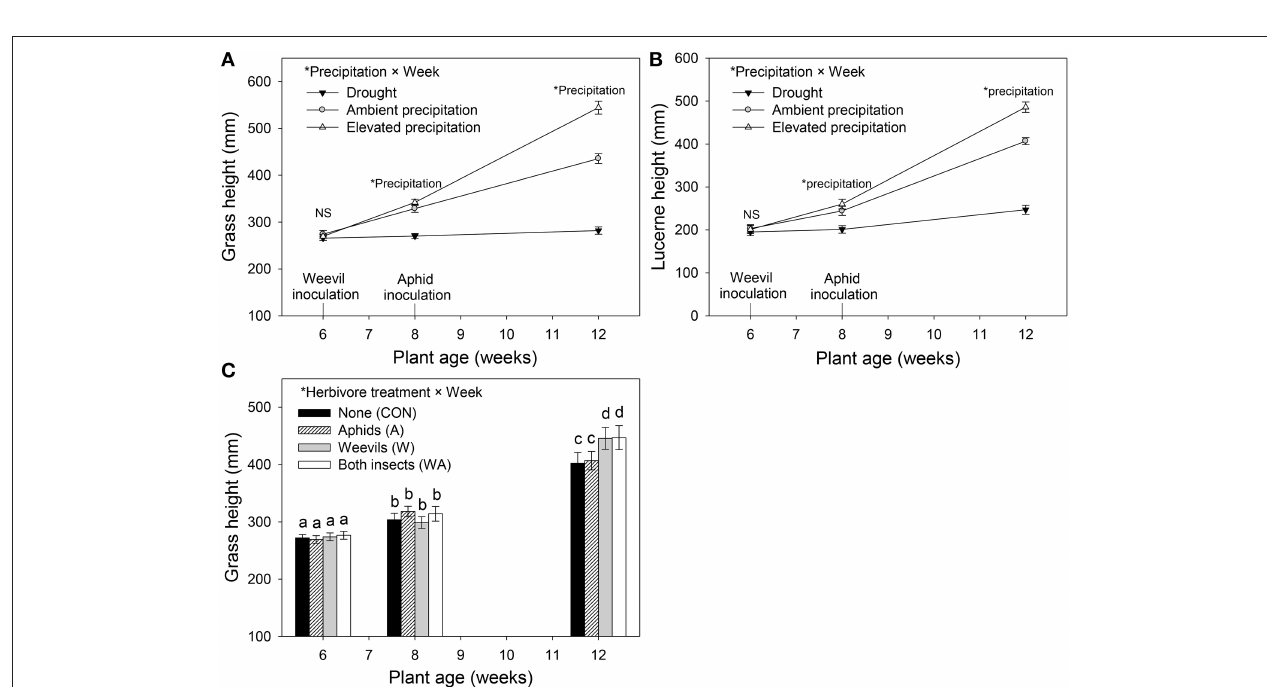
FIGURE 3 | The impacts of precipitation and herbivore treatment on the height of Harding grass (A,C) and lucerne (B) at week 6 (plant transplant period), week 8 (weevil inoculation period), and week 12 (harvest period). Herbivore treatment had no significant effect on lucerne height. Mean values ( ± SE) are shown. Statistically significant effects are indicated by * ( P < 0.05) and bars with the same letters were not significantly different ( P < 0.05).